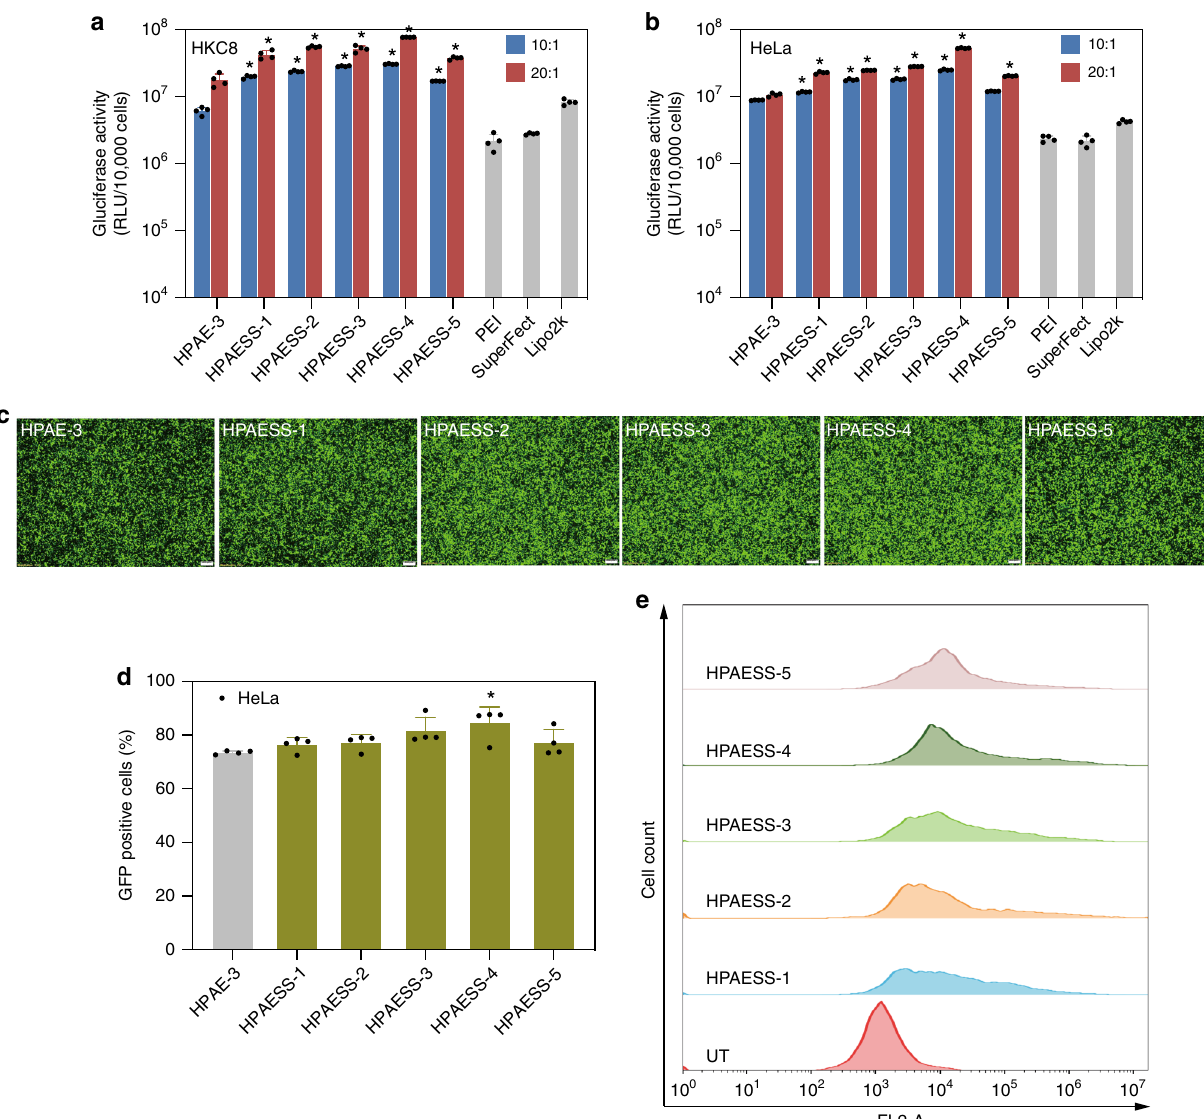
Fig. 5 Disul fi de-containing HPAESSs show higher transfection ef fi cacy than HPAE-3 and commercial reagents. a , b Gluciferase activity of HKC8 and HeLa cells after transfection with different vectors. Data points marked with asterisks (*) are statistically signi fi cantly higher relative to the HPAE-3 group. c Fluorescence images of HeLa cells 48h post transfection with various vectors at the w / w ratio of 20:1. The scale bars represent 200 μ m. d The percentage of GFP-positive cells after transfection, asterisk indicates signi fi cantly higher transfection ef fi ciency in comparison with the HPAE-3 group. e Representative histogram distributions of UT HeLa cells and the ones after transfection with HPAESSs at the w / w = 20:1. Data are shown as average±SD; n =